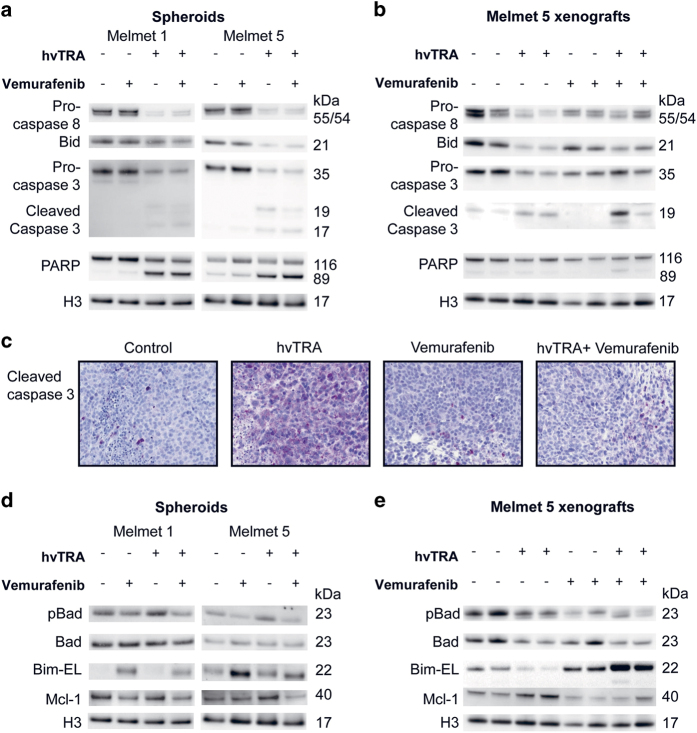
Evaluation of proteins in the extrinsic and intrinsic apoptotic pathways in response to hvTRA and vemurafenib treatment. Western immunoblot of proteins in the (a) extrinsic and (d) intrinsic apoptotic pathways in Melmet 1 and Melmet 5 spheroids in response to hvTRA (0.5 μg/ml), vemurafenib (0.3 μM) or the combination after 24 h of treatment. Two biological parallels of the spheroid experiments were performed. The results presented in (a and d) are from the same cell lysate. H3 was used as loading control. (b) Western immunoblot of proteins in the extrinsic and (e) intrinsic apoptotic pathway in Melmet 5 xenografts treated with hvTRA (3 mg/kg), vemurafenib (50 mg/kg twice a day) or the combination. Each lane in b and e represents one individual tumor. The same cell lysate is used in b and e. H3 was used as loading control. (c) Immunohistochemical detection of cleaved caspase 3 in Melmet 5 xenografts treated with hvTRA (3 mg/kg), vemurafenib (50 mg/kg twice a day) or the combination. Tumors were harvested on days 4, 2 h after the last treatment.